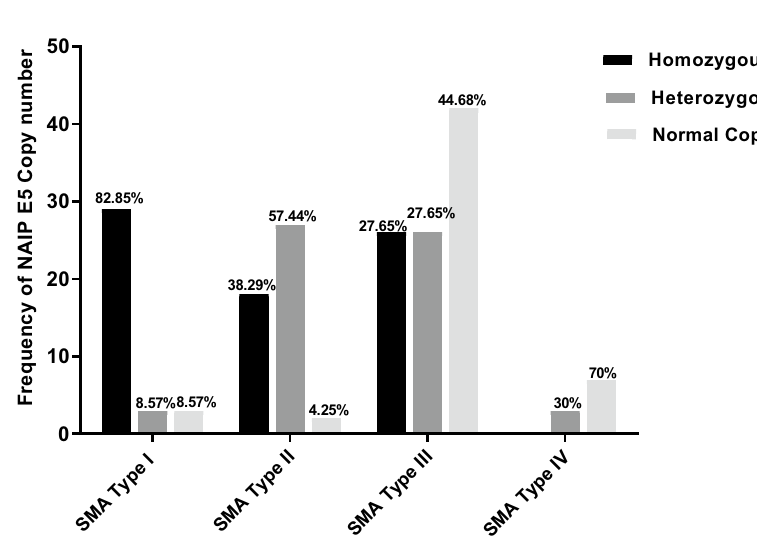
Figure 2. The percentage of individuals with various numbers of NAIP